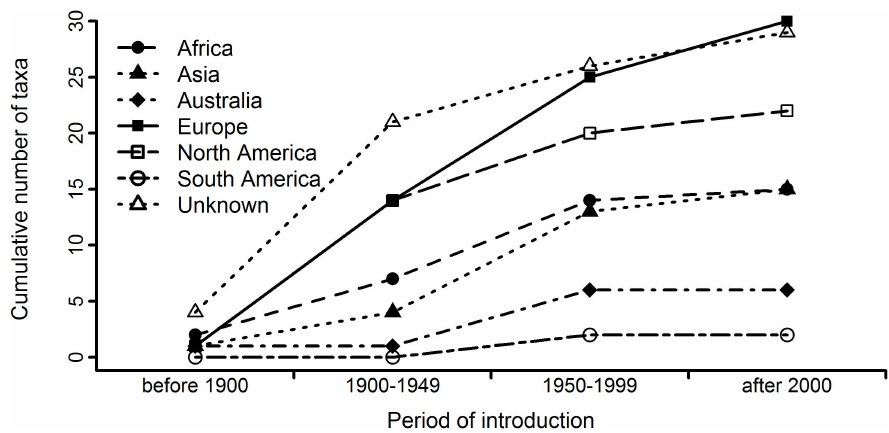
Fig 4. Temporal changes in the region of origin of marine species introduced to South Africa. Data were obtainedfrom the dataset presented in Faulkner et al. [68]. Not includedare species for which date of introduction data were not available(n = 17).